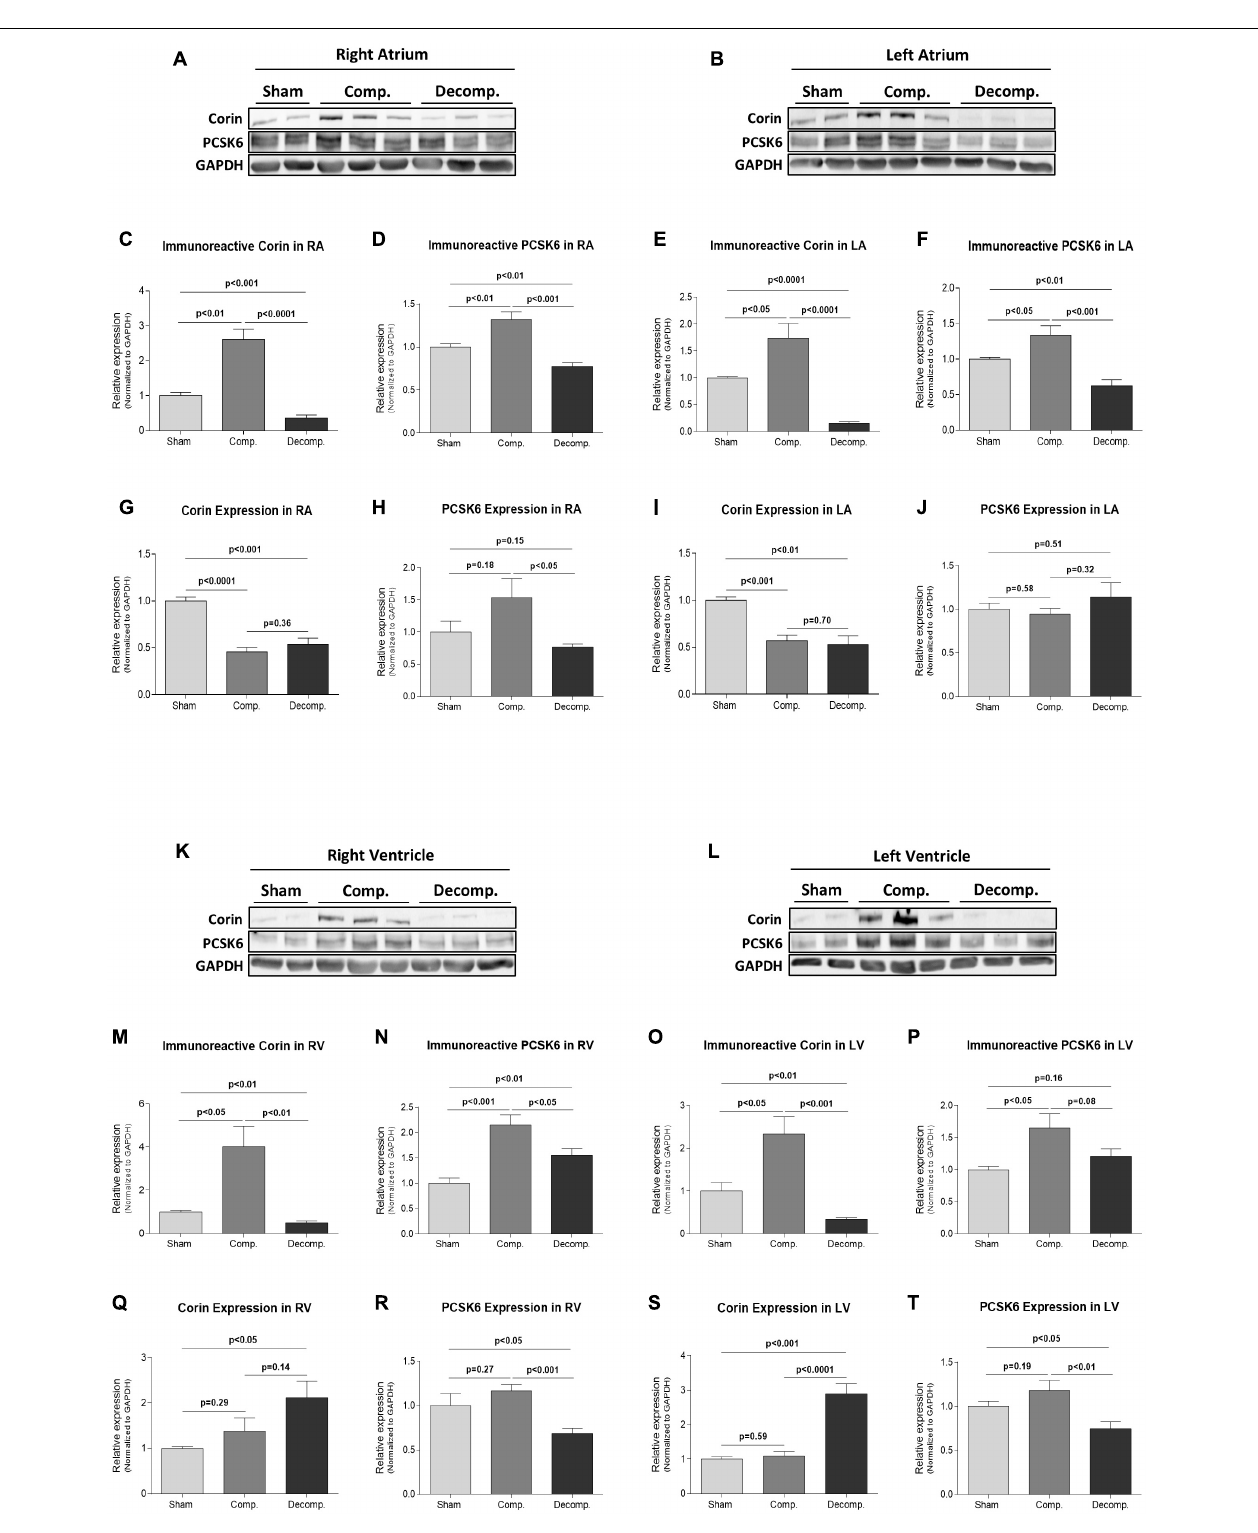
FIGURE 3 | Levels and expression of corin and PCSK6 in the cardiac tissue of compensated CHF, decompensated CHF, and sham controls. Representative western blot analysis of corin and PCSK6 in RA, LA, RV, and LV tissue lysates are shown in (A,B,K,L) , respectively. (C–F,M–P) Represent western blot analysis relative quantification of corin and PCSK6 in the different heart chambers, where GAPDH was used as a loading control. Quantification of qPCR analysis for corin and PCSK6 mRNA normalized to GAPDH are depicted in (G–J,Q–T) . Values are means ± SEM.